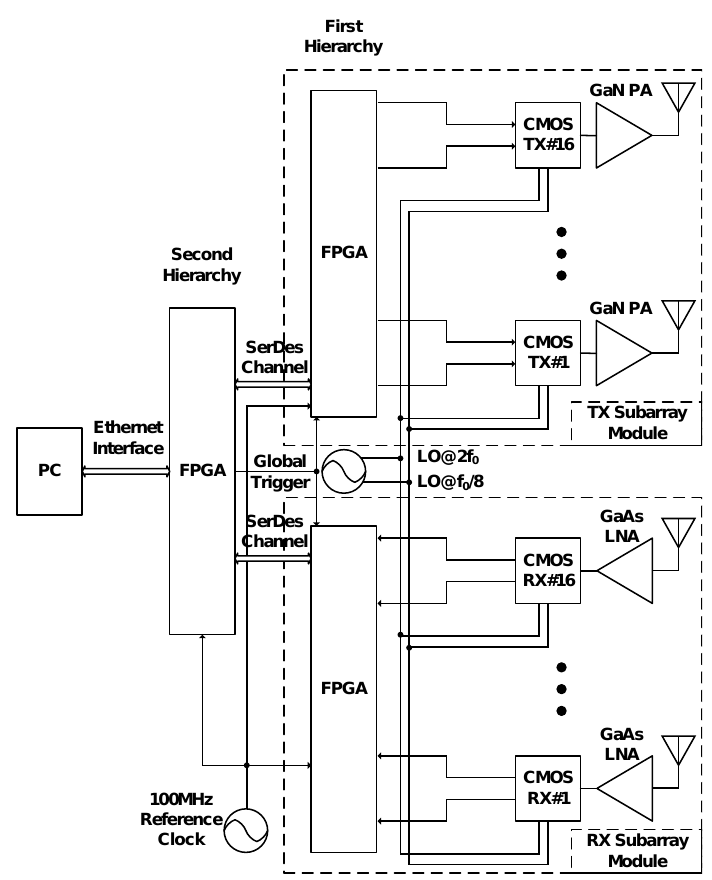
Figure 1. System architecture of the proposed digital phased array radar